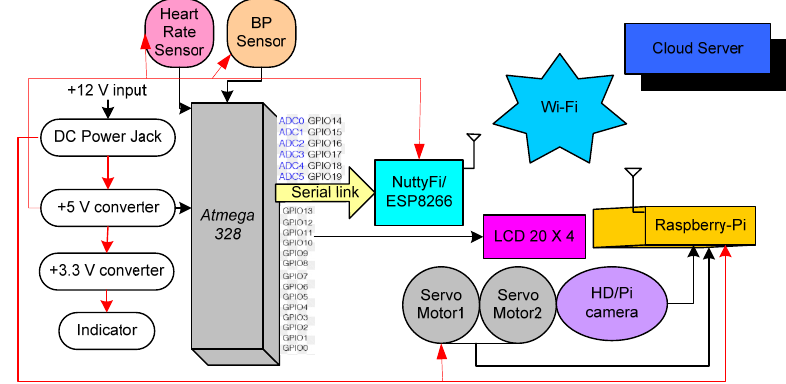
Figure 3. Block diagram of vision mote.